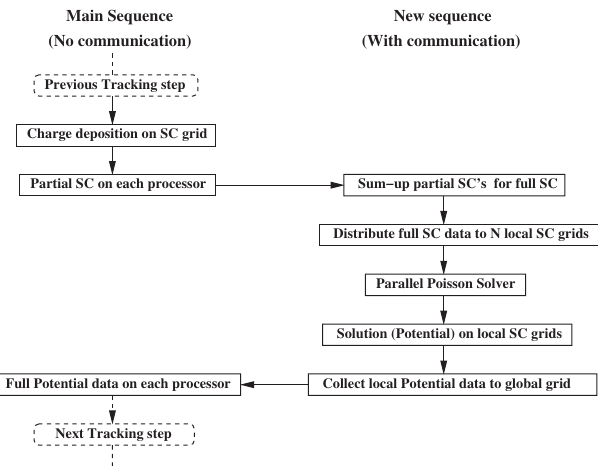
FIG. 8. The parallel model implemented into TRACK showing the main sequence similar to the serial version which does not